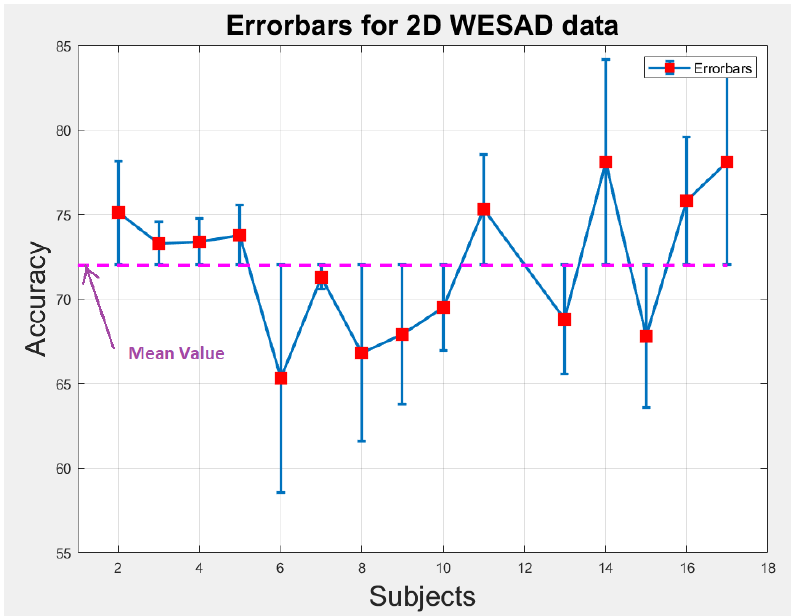
Figure 10. Error-bars showing inter-subject variability in terms of accuracy across the mean value for 2D WESAD